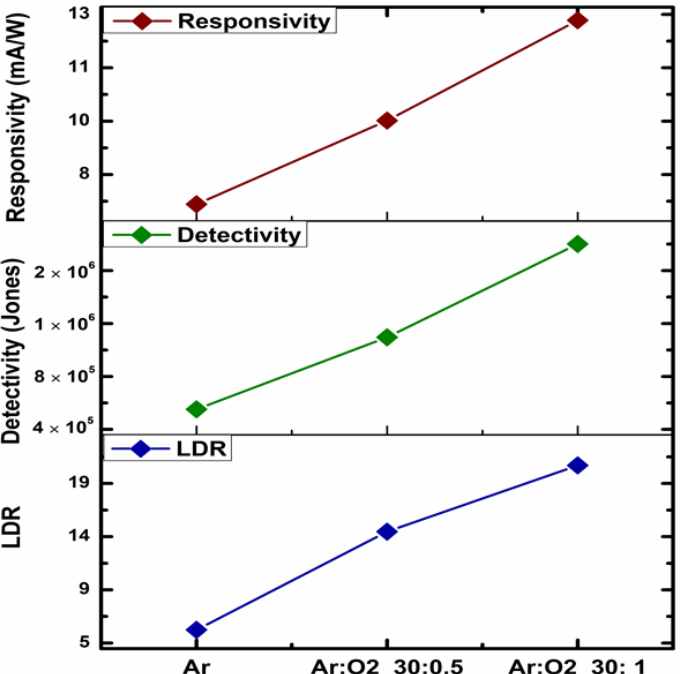
Figure 7. Responsivity, detectivity and linear dynamic range calculated for V x O y film-based heterostructures exposed to NIR wavelength (860 nm).